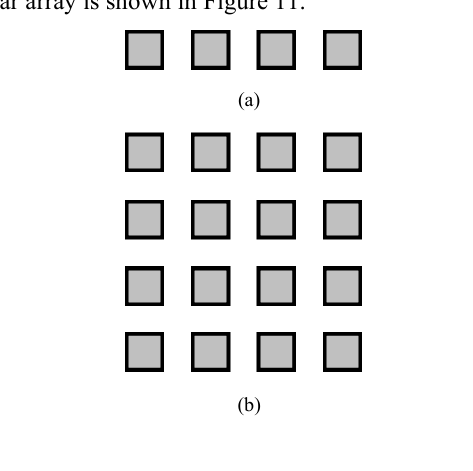
Figure 11. Antenna arrays. (a) 4-element linear array. (b) 4x4 planar